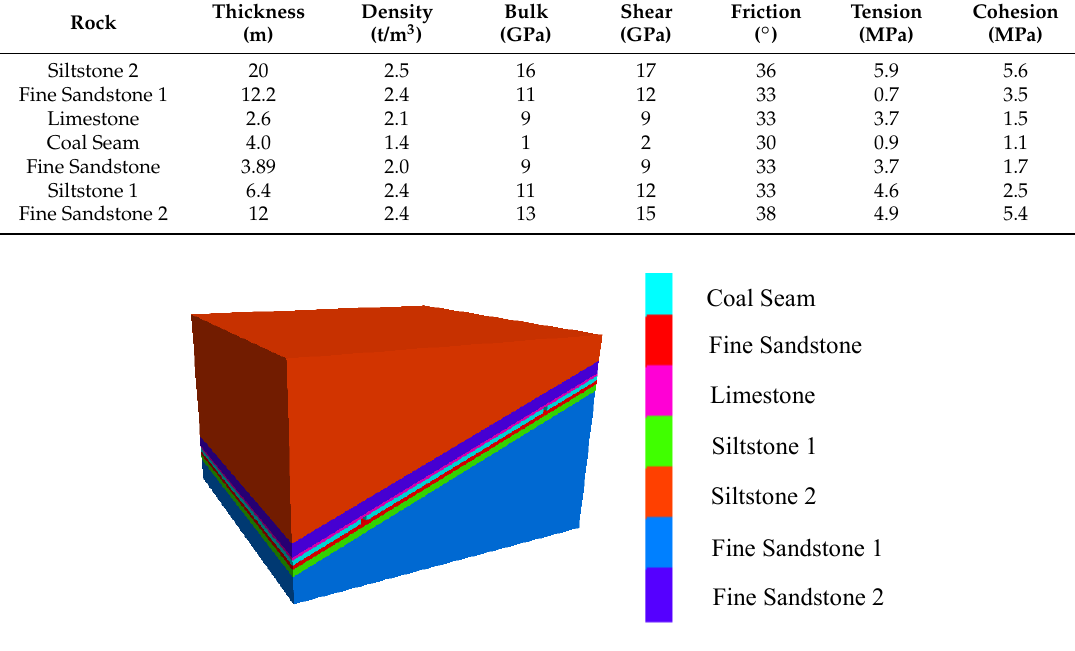
Figure 8. Numerical simulation model. Table 1. Basic physical and mechanical parameters of rock